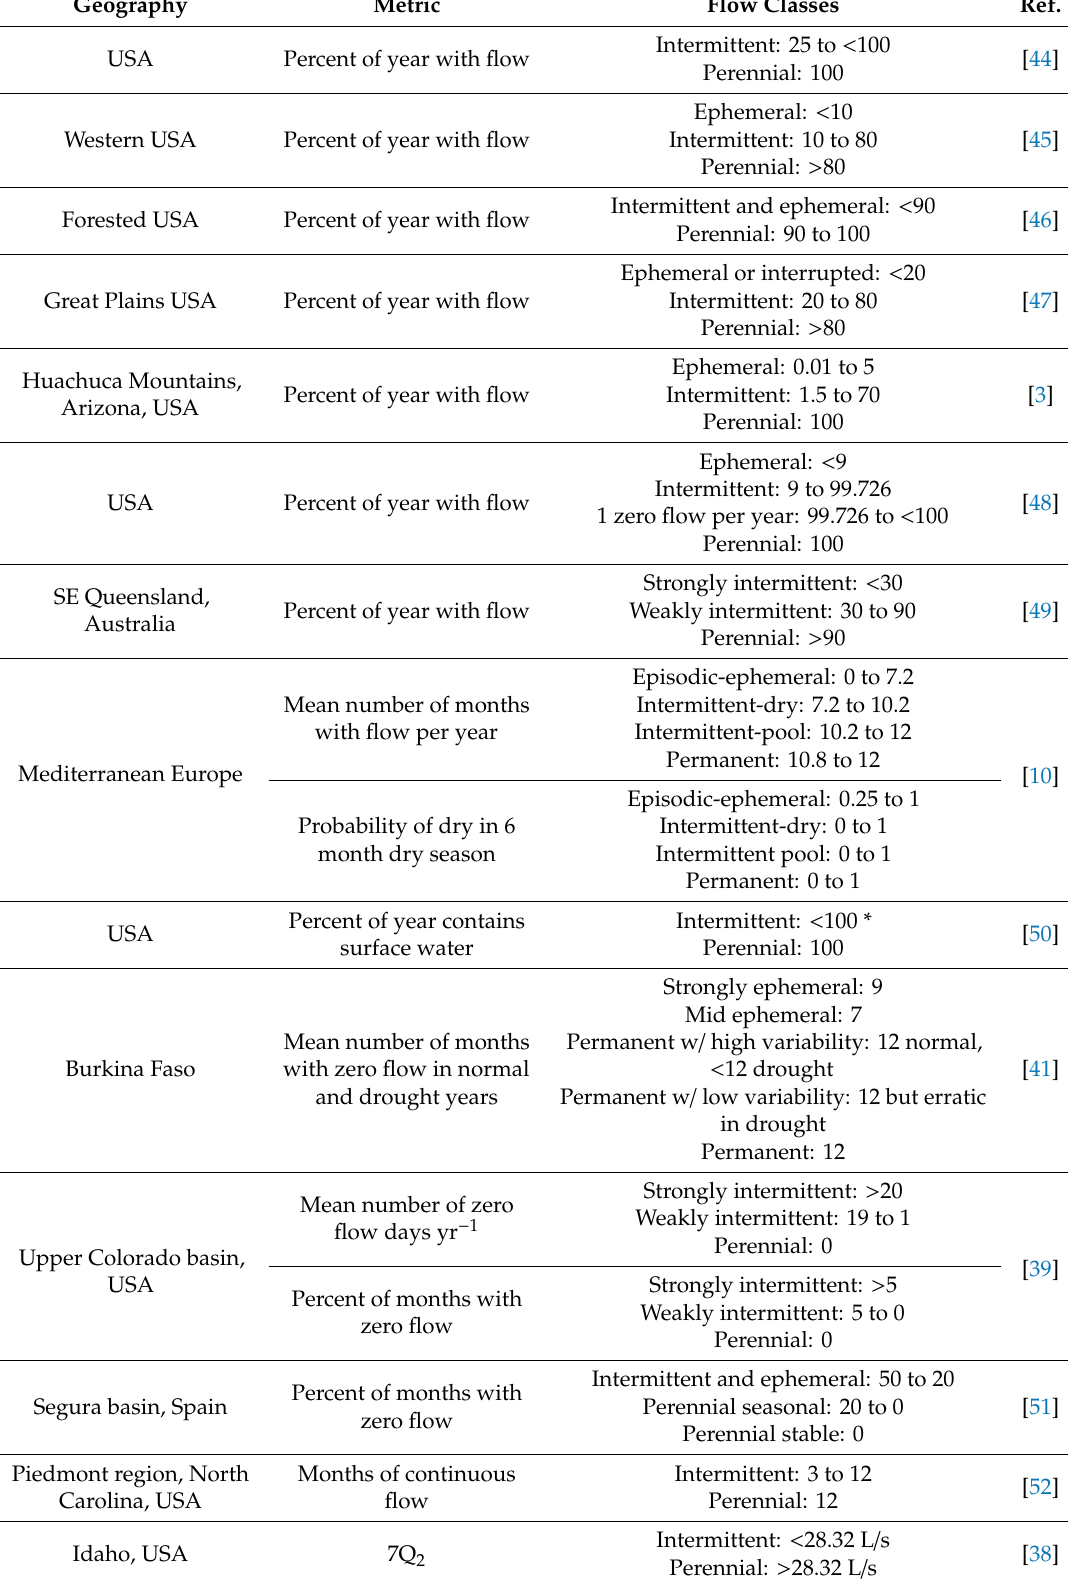
Table 2. Examples of hydrologic metrics used for flow duration classifications. Geography Metric Flow Classes Ref. Percent of year with